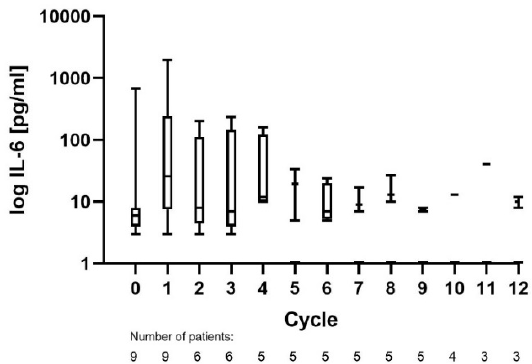
Figure 1. Peak IL-6 measurements of all treated patients during each cycle.